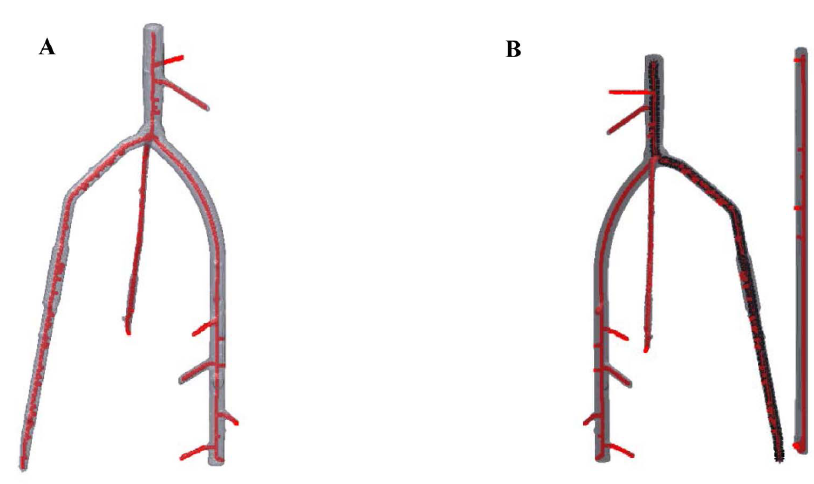
Figure 5. Demonstration of a 3D image analysis. A) Skeletonization of a 3D root image using ARIA . B) After skeletonization process is complete, the primary root is found and highlighted in black for accurate measurement of PRL measured at 1479 pixels, TRL measured at 582 pixels, and SEL with a measurement of 897 pixels. Pixel count can be converted to standard measurement notation with the inclusion of a baseline ruler to count pixels per cm or inch.